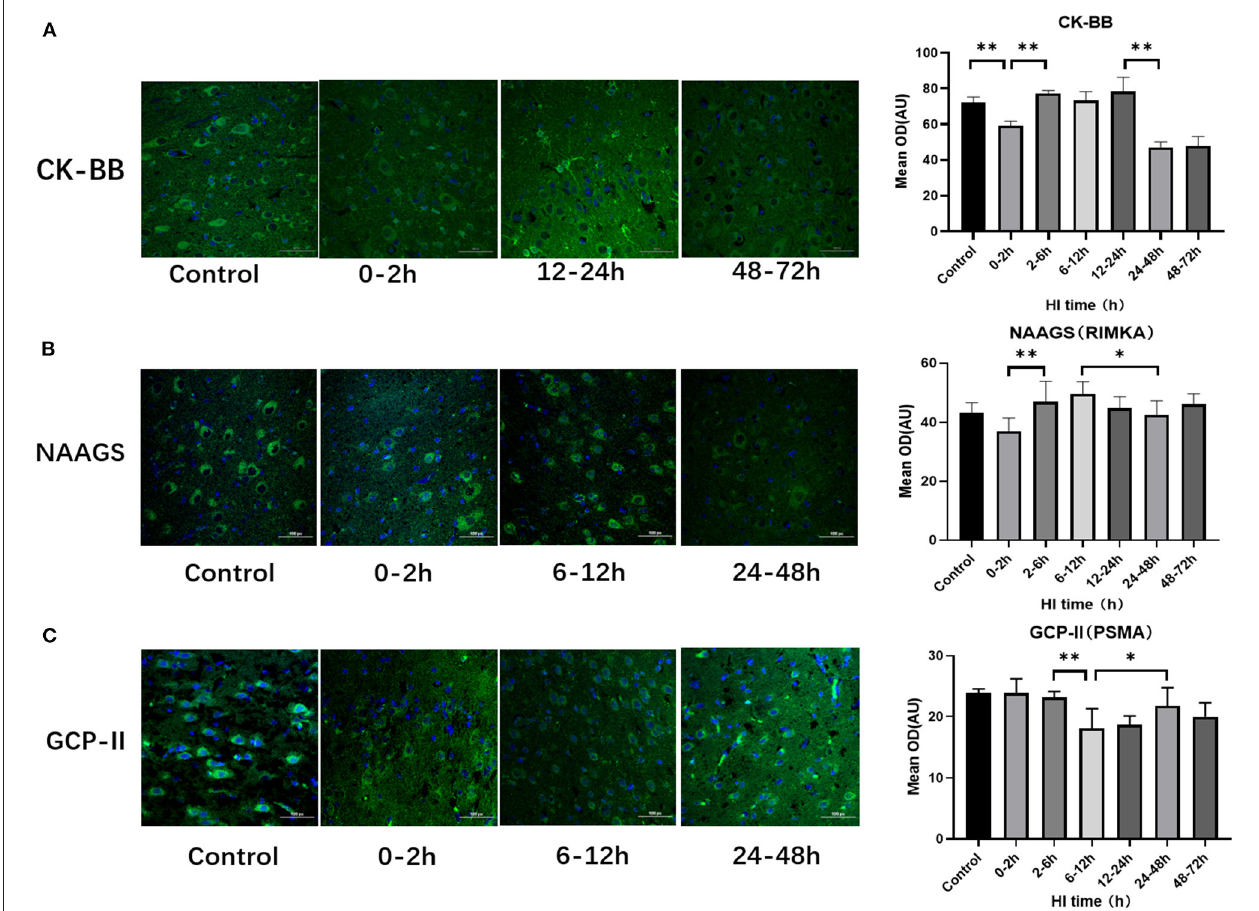
FIGURE 2 | Differences in the expression of CK-BB, NAAGS, and GCP-II after HI injury ( × 400). (A) Tendency chart for cerebral CK-BB staining and mean integrated optical density in the control group and the experimental groups at 0–2 h, 12–24 h, and 48–72 h after HI injury. Green fluorescence represents CK-BB. Compared with the control group, the fluorescence intensity decreases at 0–2 h, increases at 2-6 h, 6-12 h, 12-24 h and then decreases again at 48–72 h after HI injury. (B) Tendency chart for cerebral NAAGS staining and mean integrated optical density in the control group and the experimental groups at 0–2 h, 6–12 h, and 24–48 h after HI injury. Green fluorescence represents NAAGS. The fluorescence intensity of NAAGS reaches its peaks at 2–6 h and 6–12 h after HI injury. (C) Tendency chart for cerebral GCP-II staining and mean integrated optical density in the control group and the experimental groups at 0–2 h, 6–12 h, and 24–48 h after HI injury. Green fluorescence represents GCP-II. The fluorescence intensity of GCP-II decreases at 6–12 h, increases at 24–48 h after HI injury. ** P < 0.01, * P < 0.05, and data are expressed as mean ± standard